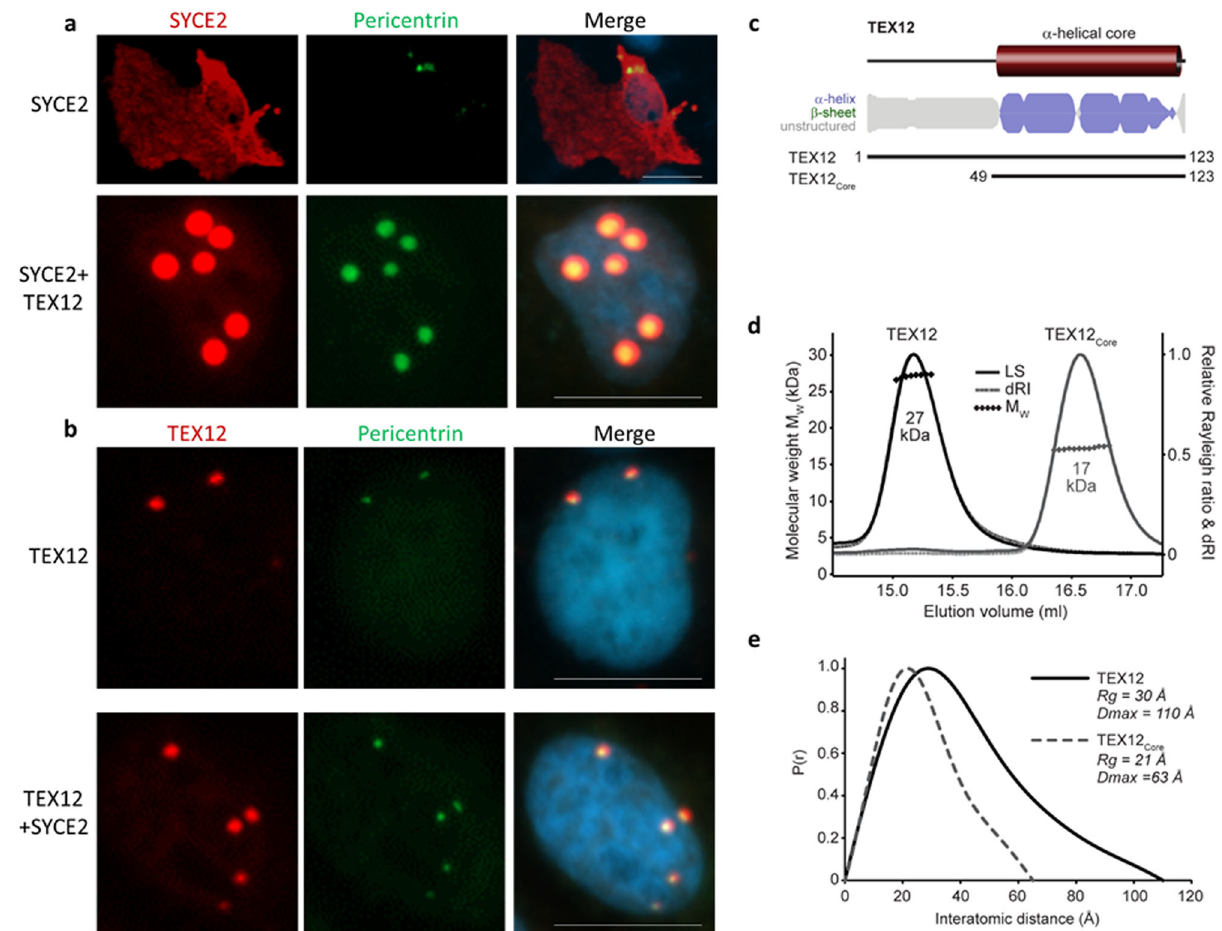
Fig. 4 TEX12 forms a stable α -helical dimer and can localise to centrosomes independently of its SC partner, SYCE2. a COS-7 cells were transfected with SYCE2 and TEX12 as indicated. Cells were stained for SYCE2 (red) and pericentrin (green). Nuclei were visualised in blue with DAPI. Bar = 20 µ m. b COS-7 cells were transfected with SYCE2 and TEX12 as indicated. Cells were stained for TEX12 (red) and pericentrin (green). Nuclei were visualised in blue with DAPI. Bar = 20 µ m. c Sequence analysis of human TEX12 demonstrating the presence of a core α -helical region in the C-terminal half of the protein. Secondary structure prediction is shown as per residue scores and protein constructs are indicated along with their sequence boundaries. d SEC- MALS analysis of TEX12 and TEX12core in which light scattering (LS) and differential refractive index (dRI) are overlaid, with and fi tted molecular weights (Mw) plotted as diamonds across elution peaks. TEX12 and TEX12core are both dimeric, with molecular weights of 27 kDa and 17 kDa, respectively (theoretical dimer sizes − 28 kDa and 18 kDa). e SEC-SAXS analysis of TEX12 and TEX12core. P(r) distributions of TEX12 (solid line) and TEX12core (dashed line) showing maximum dimensions of 110 Å and 63 Å,